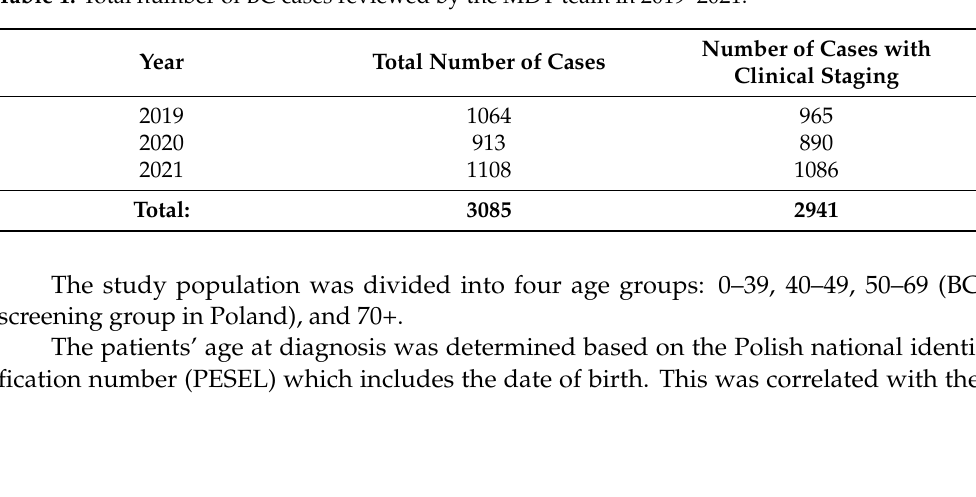
Number of Cases with Clinical